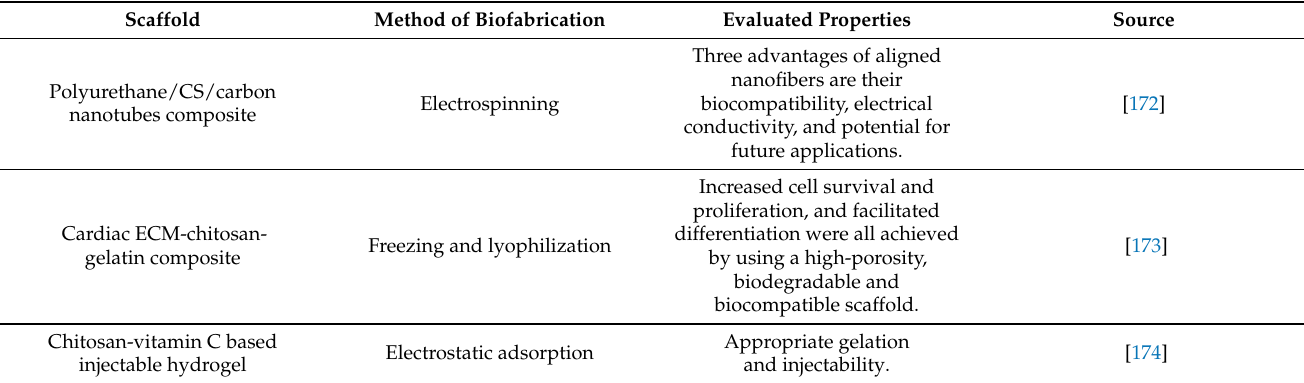
Table 5. Chitosan-based scaffolds for heart tissue engineering.